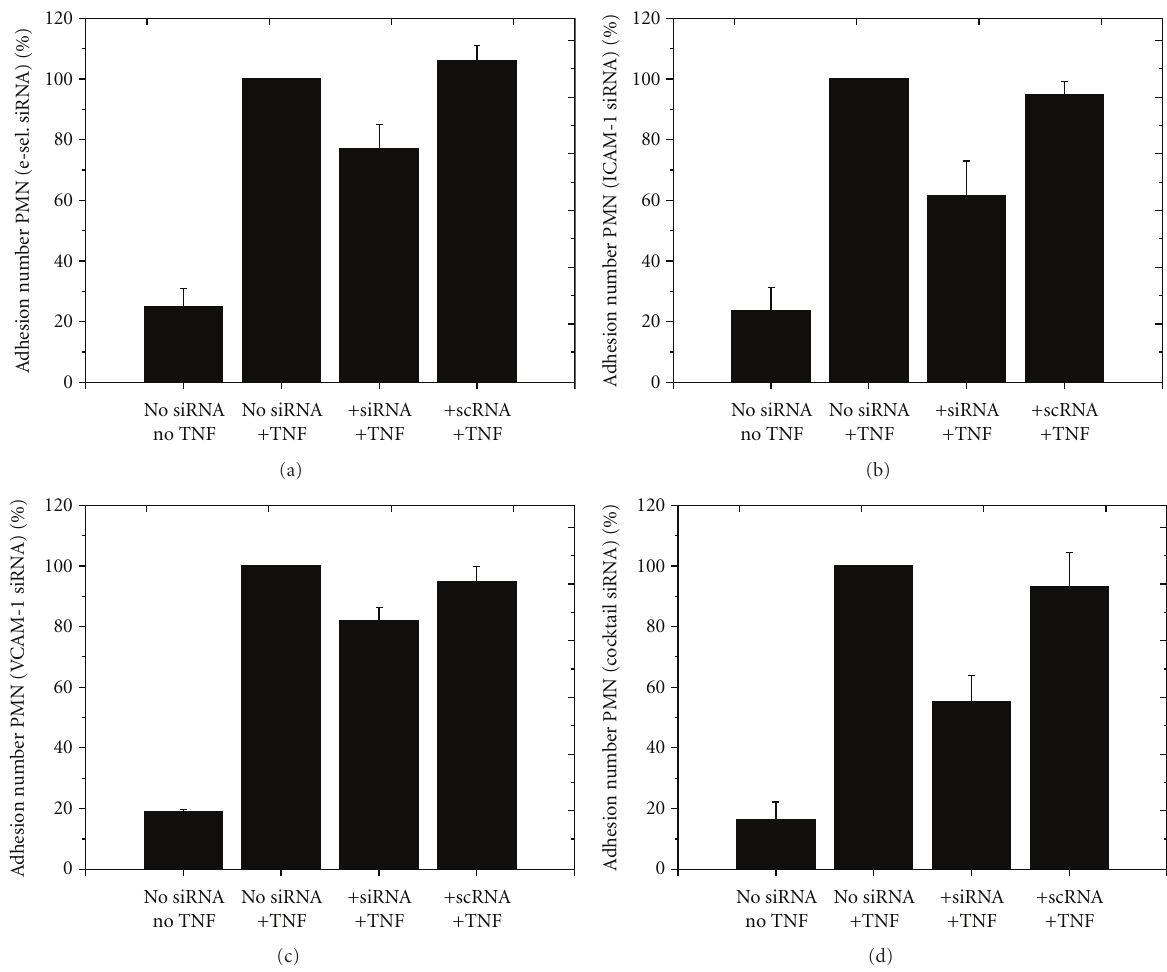
Figure 6: E ff ects of siRNA and TNF- α treatment on binding of neutrophils to confluent layers of HLMECs. The y -axis reflects the respective adhesion of neutrophils (in %), whereby untreated cells stimulated with TNF- α (group 2) were set to 100%. x -axis: group 1: HLMECs without siRNA transfection and without TNF- α stimulation; groups 2: HLMECs without siRNA transfection, but with TNF- α stimulation; group 3: HLMECs transfected with specific siRNAs targeting ESELE (a), ICAM-1 (b), VCAM-1 (c), or all 3 di ff erent siRNAs simultaneously (d) plus TNF- α stimulation; group 4: HLMECs transfected with a nonspecific siRNA and with TNF- α stimulation. Each bar represents the mean ± SD of n = 3 independent experiments, each performed in